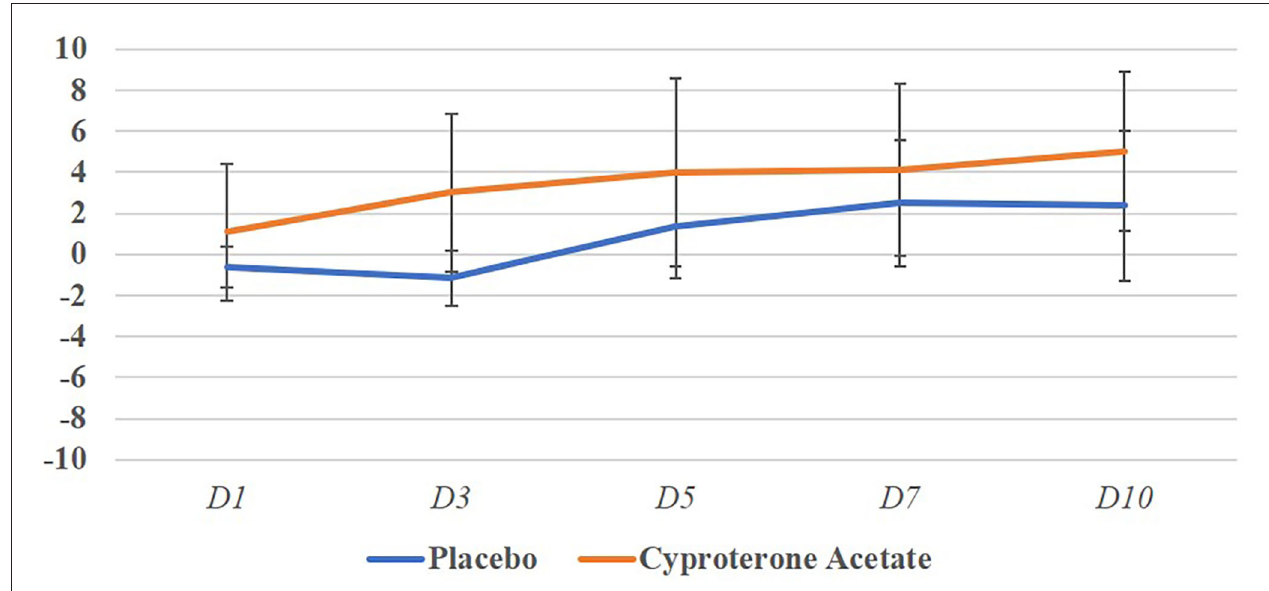
FIGURE 2 | Mean behavioral scores per days and treatment groups.